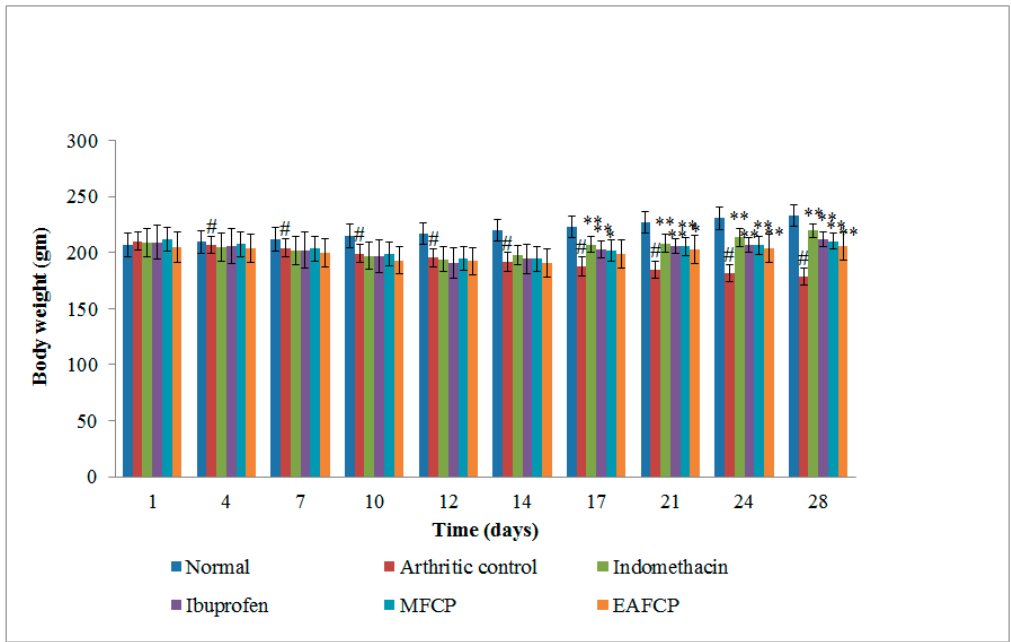
Figure 3. Effect of Swallow wort fractions on body weight. Values are mean ± SEM for 6 animals; statistical analysis by one-way ANOVA followed by Dunnett test using GraphpadInstat software; * p < 0.05, ** p < 0.01 when compared to arthritic control, and # p < 0.01 when compared to normal control.